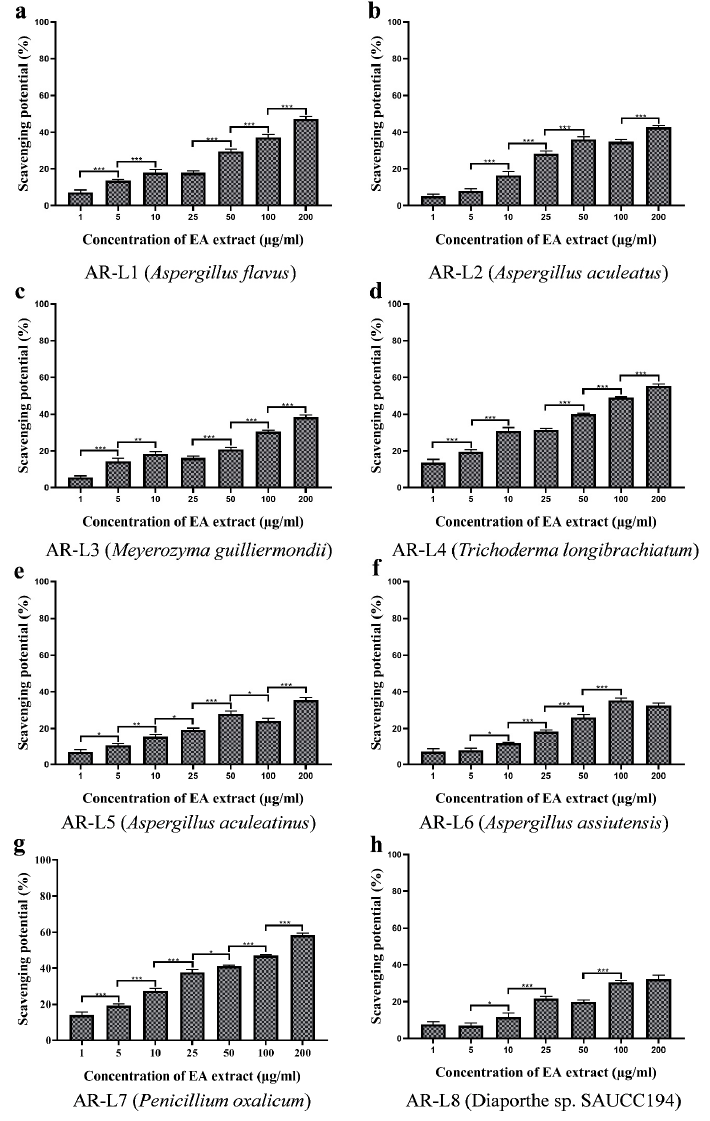
Figure 5. Hydroxyl radical scavenging potential of EA extract of fungal endophytes ( a ) A. flavus , ( b ) A. aculeatus , ( c ) M. guilliermondii , ( d ) T. longibrachiatum , ( e ) A. aculeatinus , ( f ) A. assiutensis , ( g ) P. oxalicum and ( h ) Diaporthe sp. SAUCC194. All the experiments were performed in triplicate. p -value was calculated by comparing means ± SD of the hydroxyl radical scavenging potential (%), using one-way ANOVA followed by Tukey to determine statistical significance, which are as follows; *** p ≤ 0.001; ** p ≤ 0.002; * p ≤ 0.033.